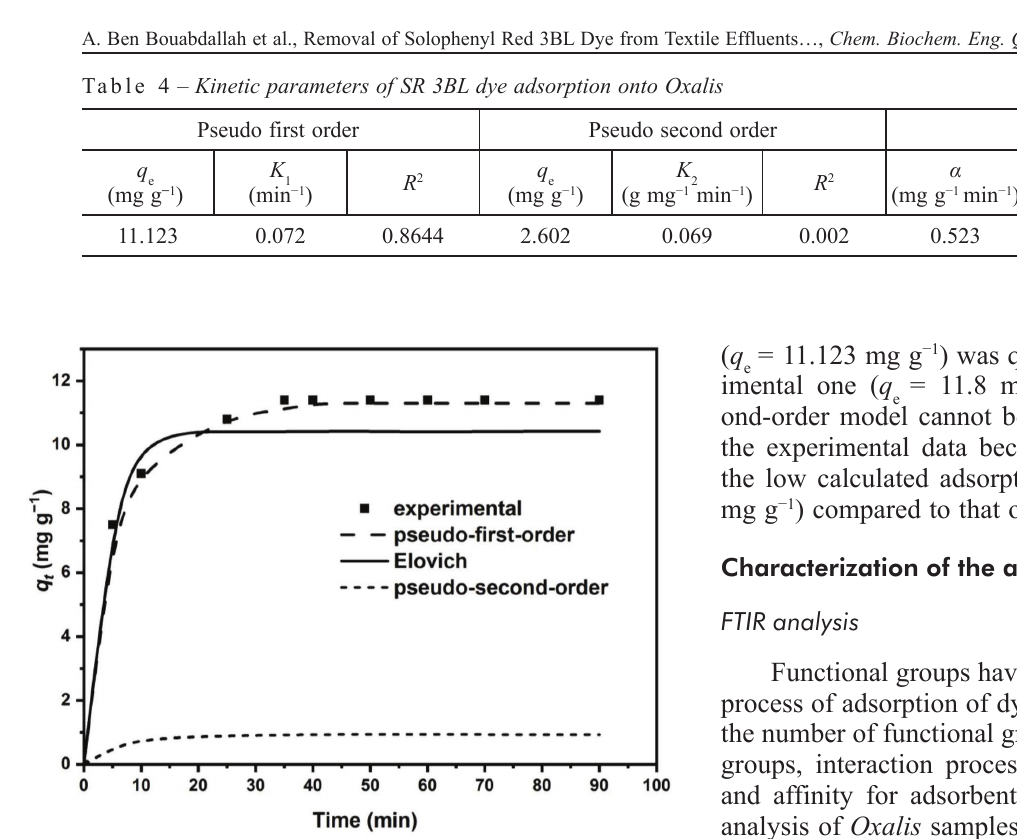
Fig. 5 – Nonlinear plots of pseudo first order, pseudo second order, and Elovich kinetic models for the adsorption of SR 3BL onto Oxalis (experimental conditions: adsorbent dose 1 g L −1 , pH 6, initial dye concentration 50 mg L –1 , contact time 35 min,